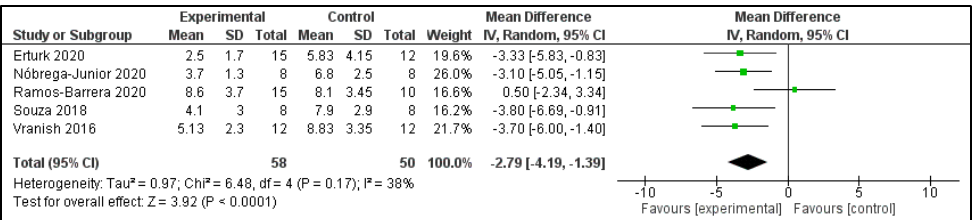
Figure 5. Forest plot for Epworth sleepiness scale.